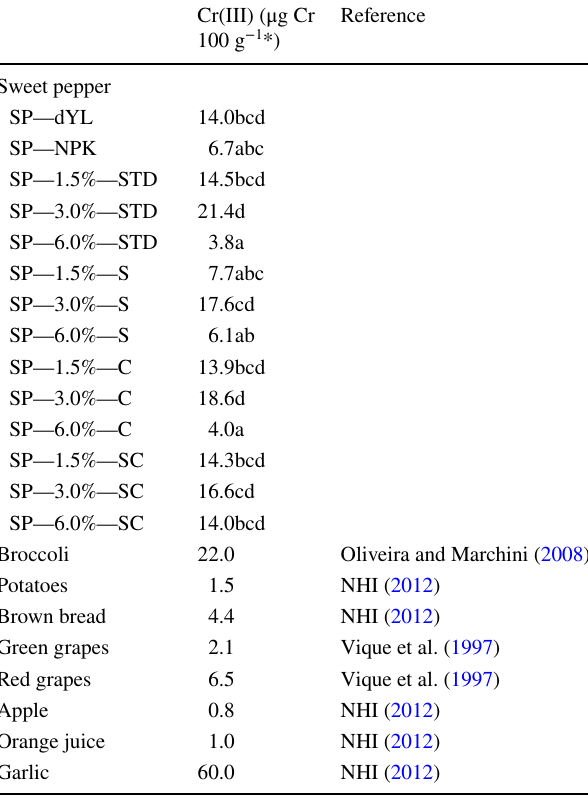
Table 9 Cr(III) concentration in the cropped red sweet pepper and comparison with those in other foods found in the